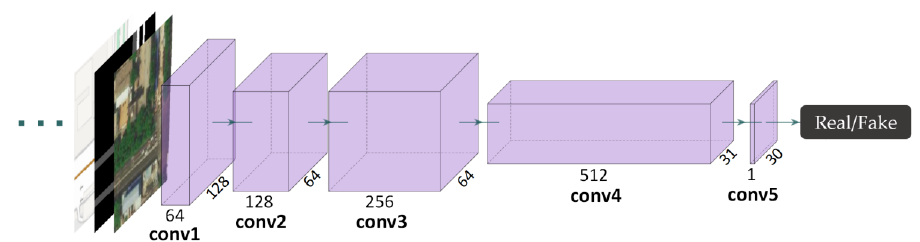
Figure 5. The discriminator architecture of MapGAN.